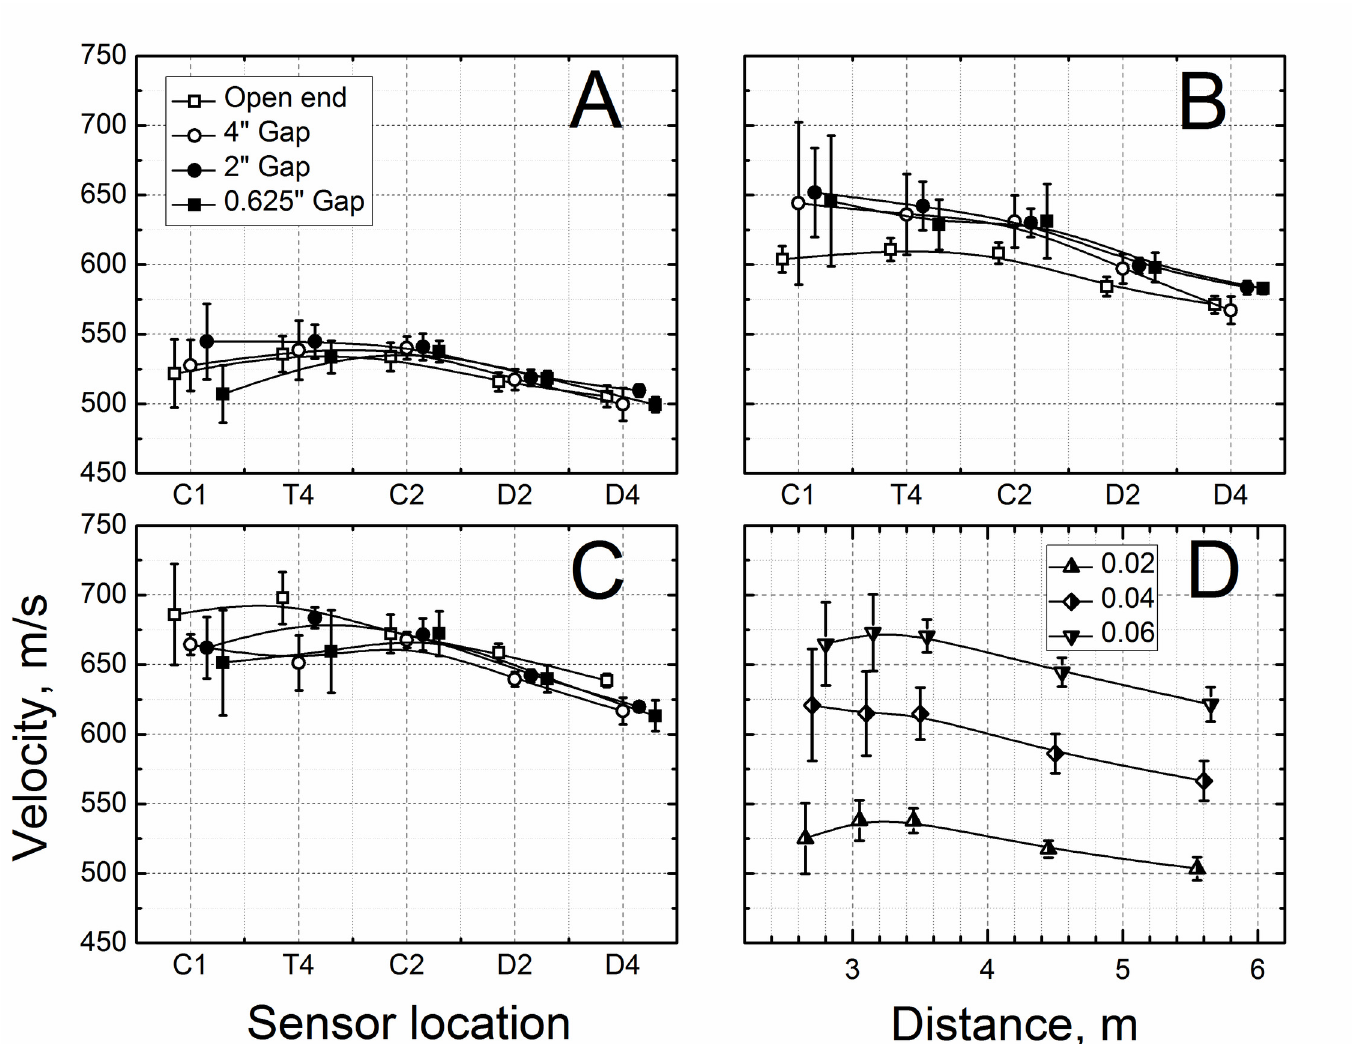
Fig 3. Calculated shock wave velocities at different sensor locations as a function of BOPs generated using Mylar membranes with thicknesses of: A) 0.02 ” , B) 0.04 ” , and C) 0.06 ” . Shock wave velocities were averaged for all experiments preformed using the same Mylar membrane thickness (D). Individual data points were horizontally shifted for clarity of presentation. The B1 sensor was used as a reference for all